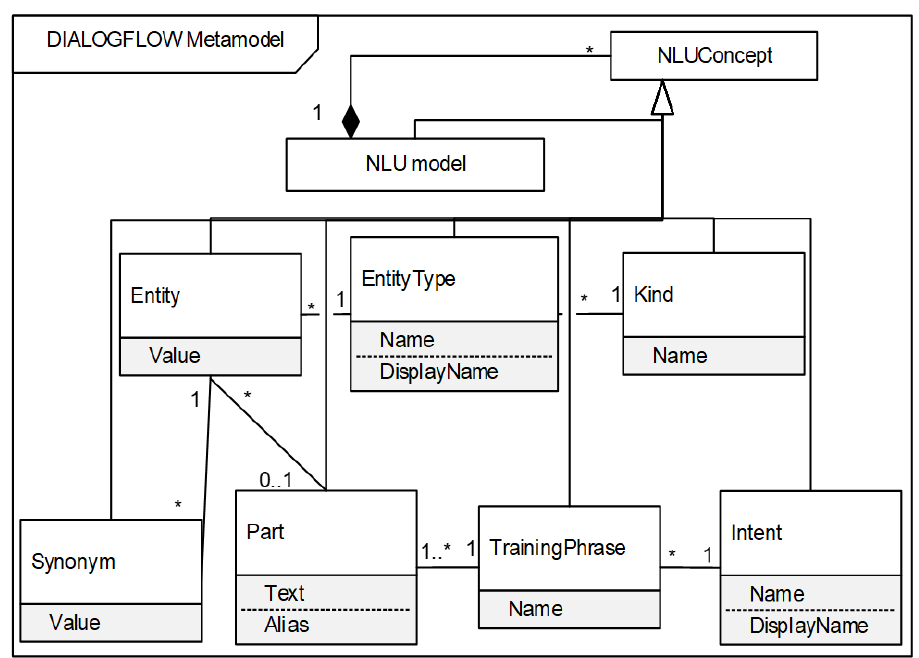
Figure 4. Dialogflow